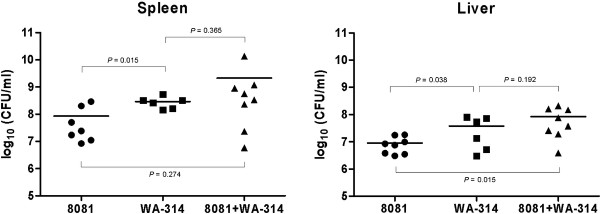
 Mouse infection experiments. Bacterial counts in spleens and livers of mice infected with Y. enterocolitica strain 8081, Y. enterocolitica strain WA-314 and of co-infected mice with both strains are indicated. The means log10(CFU/ml) are displayed as error bars.